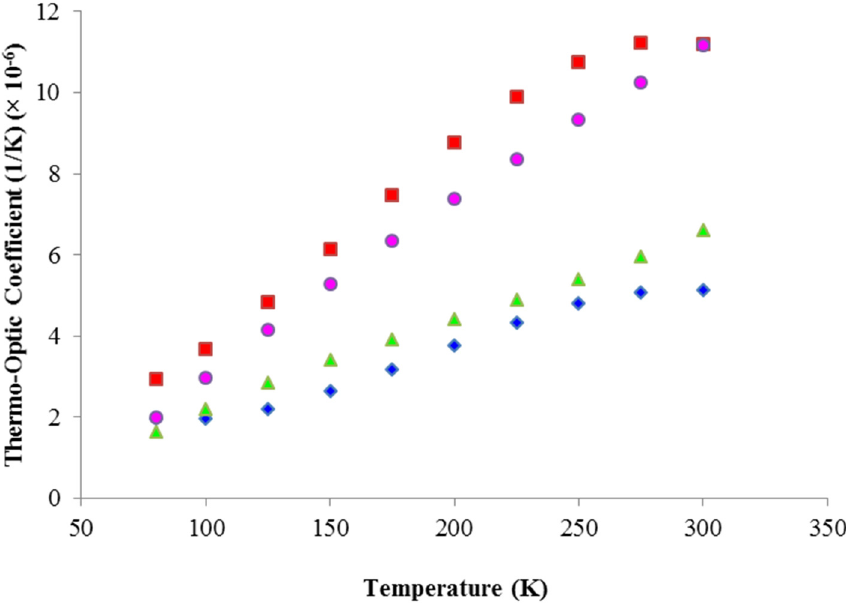
Figure 30. Thermo-optic coefficient as a function of absolute temperature for YYO 4 a (red) and c (Blue) axes [30] and GdVO 4 a (pink) and c (green) axes [3], measured at a wavelength of 1064 nm.